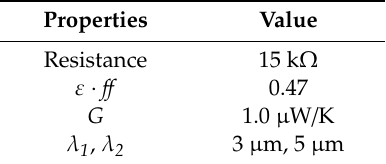
Table 2. Target IR emitter properties.